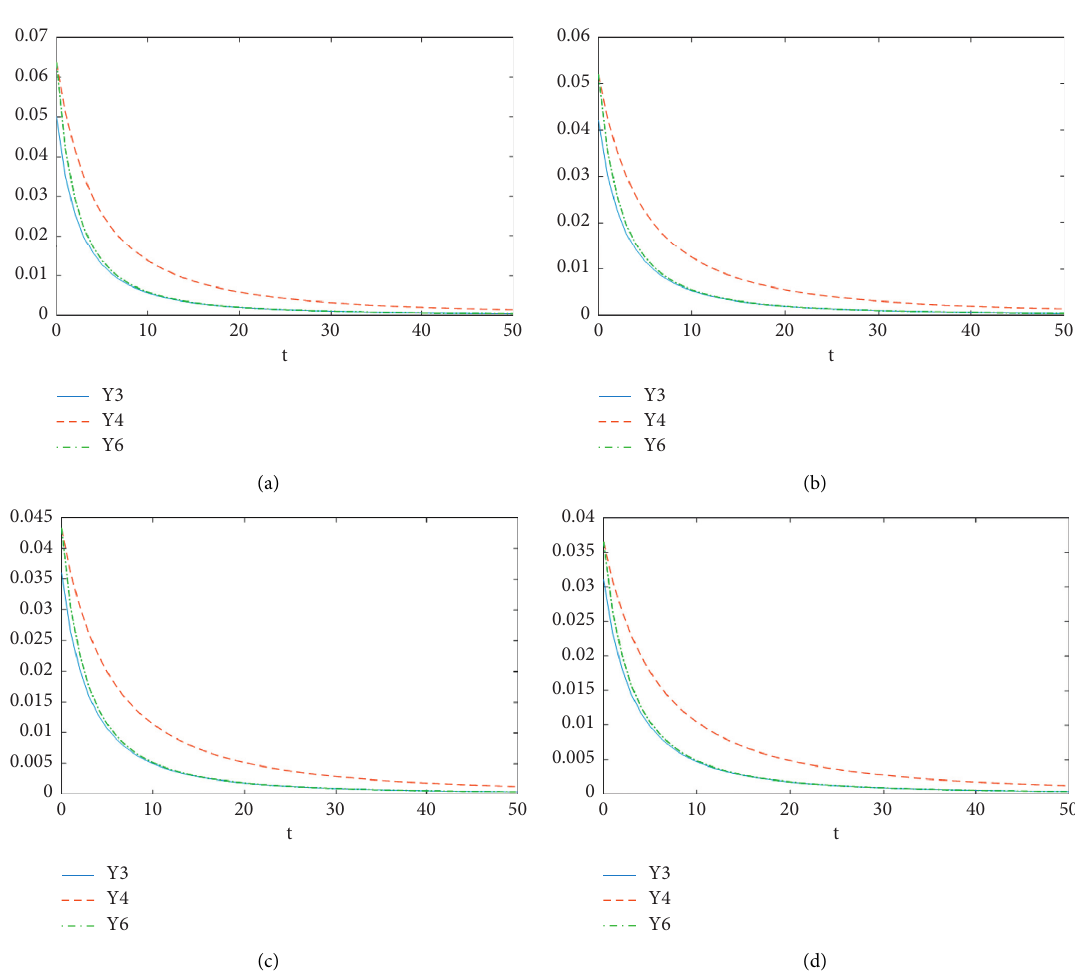
� 4 . 3, s � 5 . 0). (a) β � 0 . 2. (b) A B